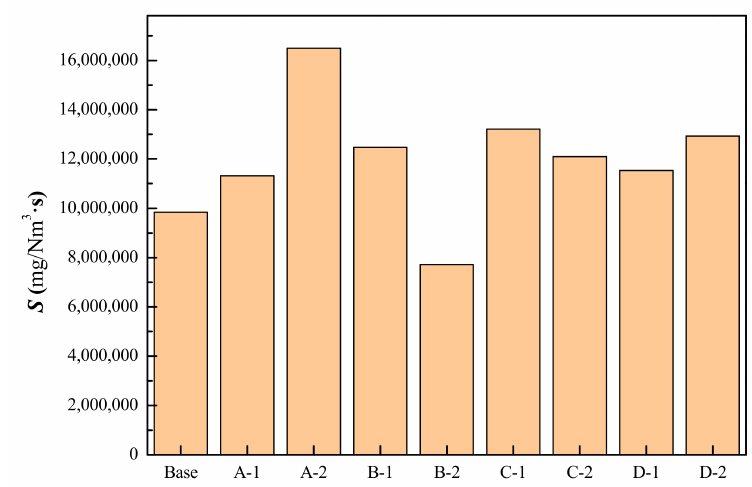
Figure 15. Influences of the sinter parameters on CO emission.